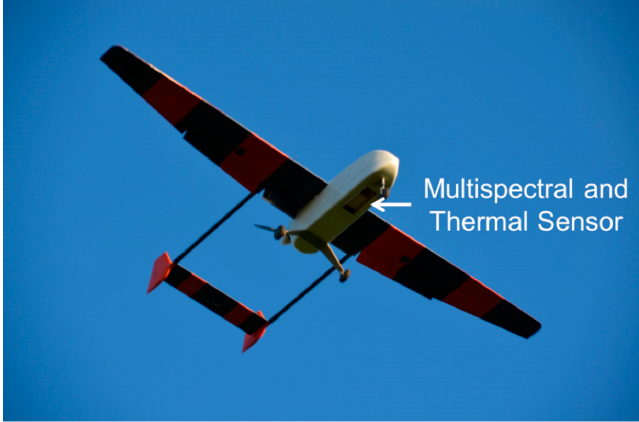
Figure 2. The Carolo P360 unmanned aerial vehicle (UAV) during a mission with open landing gear